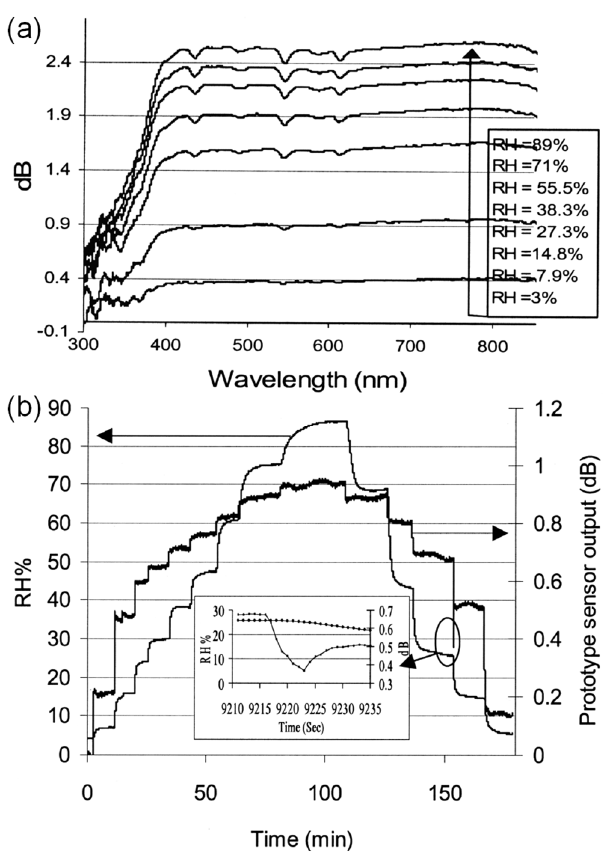
Figure 8. Point sensor. ( a ) Wavelength response to different RH. ( b ) Temporal responses of the humidity sensor. Adapted with permission from ref. [35]. Copyright 2004 OSA